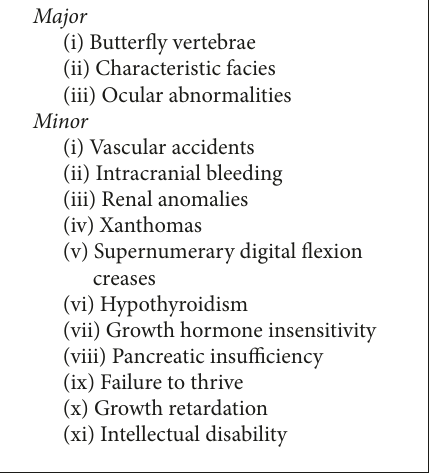
Box 1: Abnormalities of Alagille Syndrome [1, 3, 4].